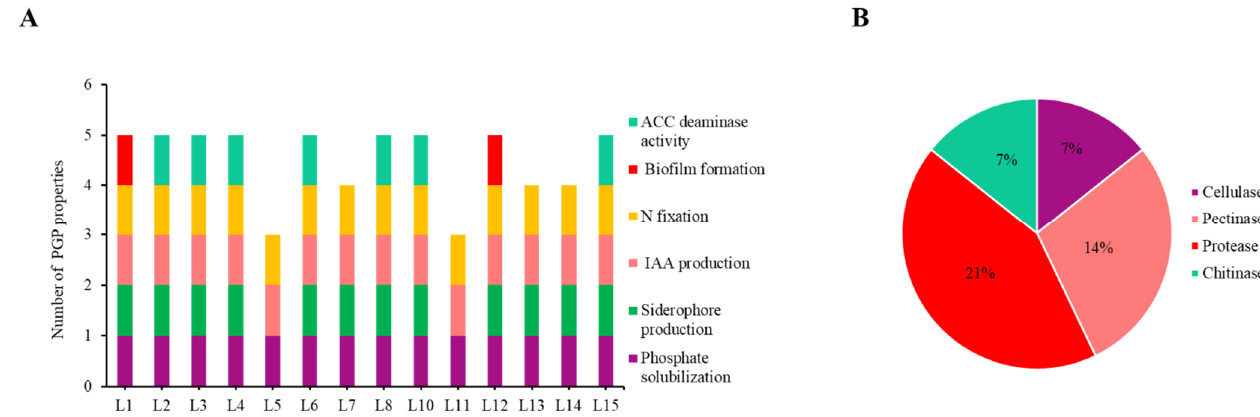
Figure 1. Characterization of isolated bacteria. ( A ) Number of PGP properties in each strain; X-axis indicated the different isolated strains. ( B ) Percentage of enzymatic activities in the isolates.